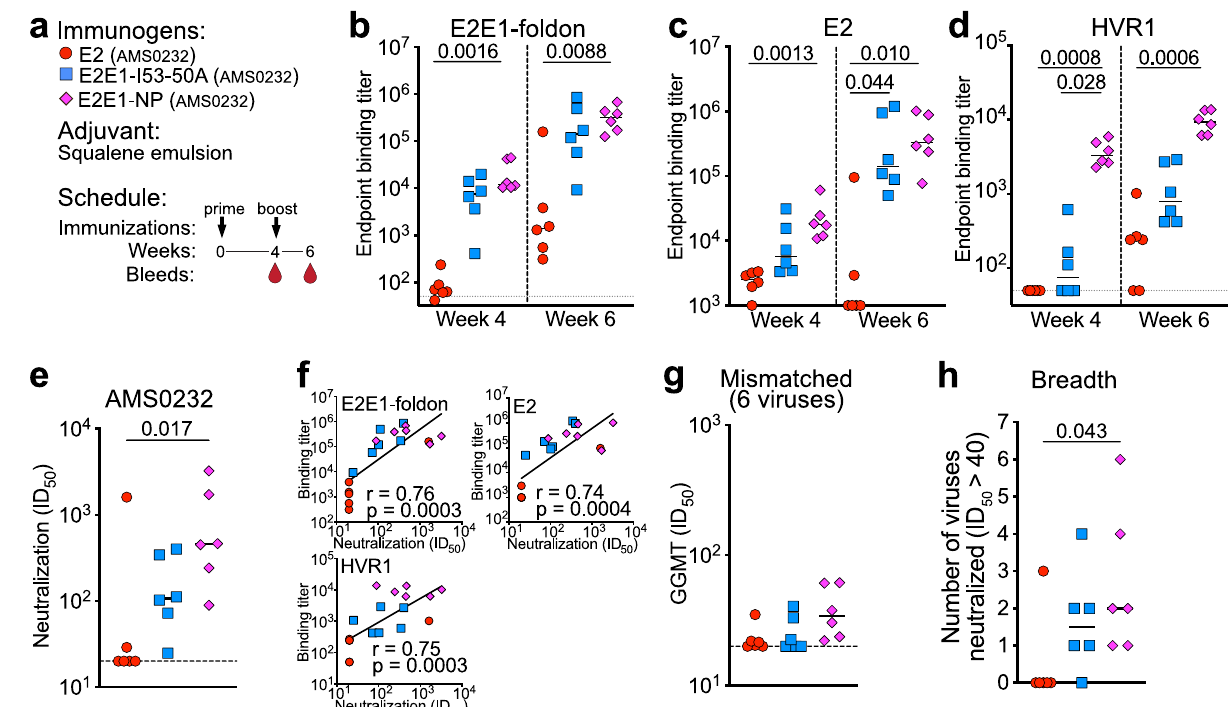
Fig. 2 | ImmunogenicityofE2E1-NPsin rabbits.a Rabbitimmunization schedule. Six rabbits were immunized with E2 monomers, E2E1-I53-50A trimers, or E2E1-NP (10 µ gE2,orequimolaramountofE2)atweeks0and4.Bleedsweretakenatweeks 4and6.Allimmunogensarebasedonthegenotype1aAMS0232strain. b – d Rabbit serumbindingtiterstoE2E1-foldontrimers( b ),E2monomers( c ),andHVR1( fi rst27 amino acids of AMS0232 E2) ( d ). e Neutralization titers measured against the sequence-matched AMS0232 HCVpp. f Correlations between autologous neu- tralization ( e ) and binding titers ( b – d ). Spearman r and p -values (two-tailed) are indicated. g Global geometric mean titers (GGMT) were calculated based on the